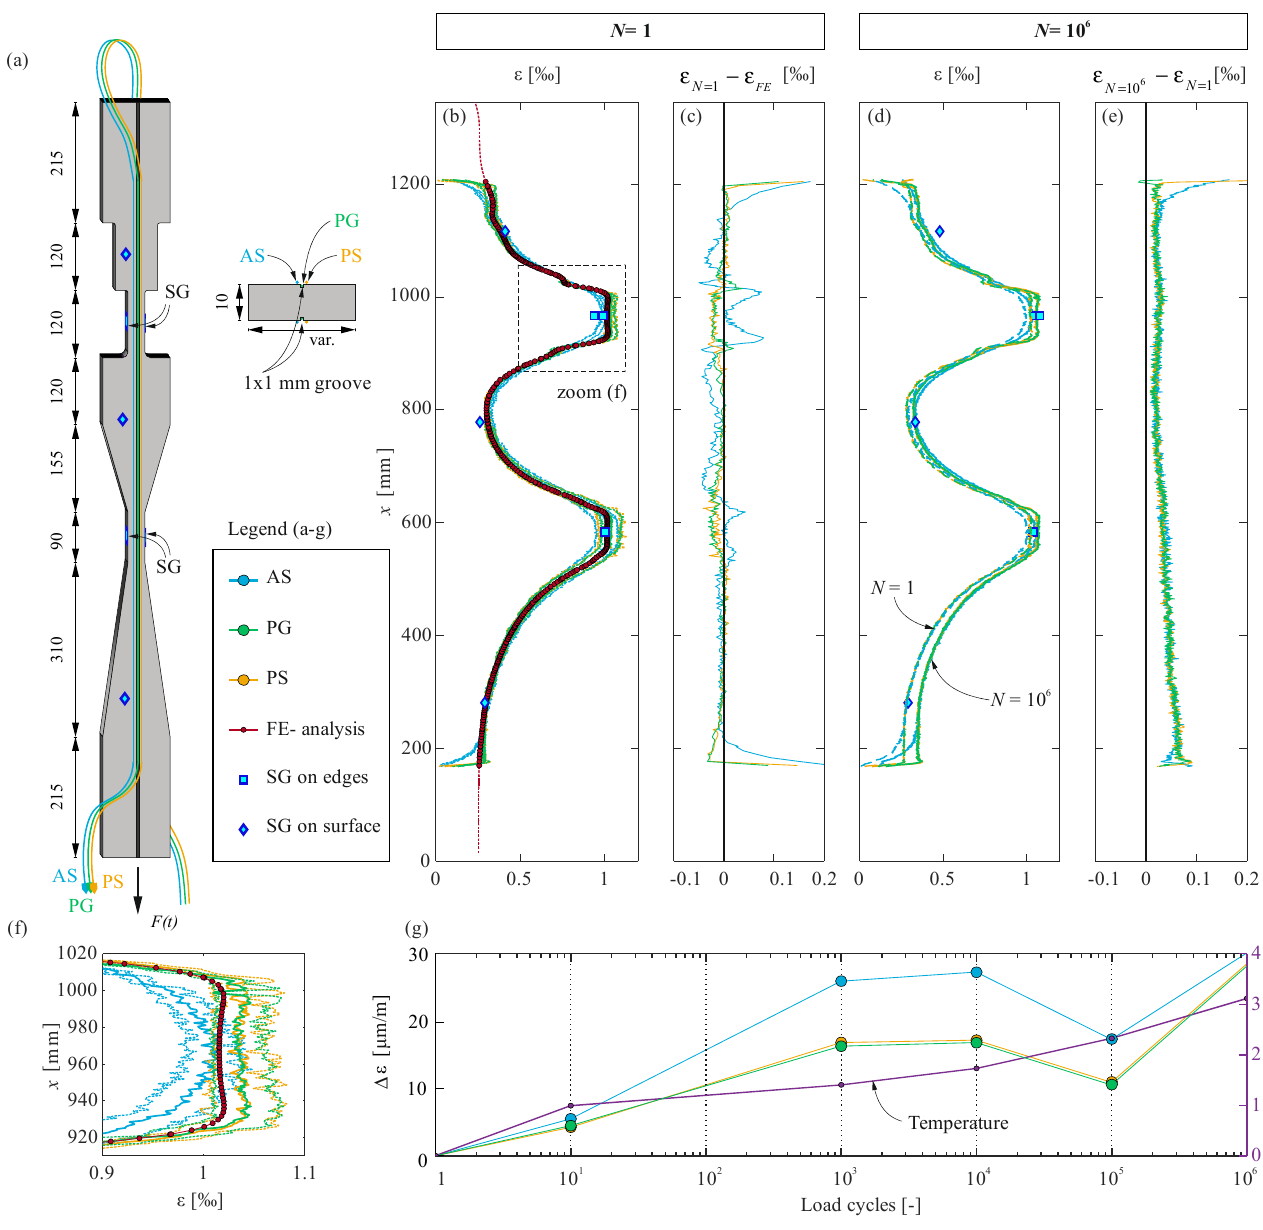
Figure 2. Influence of discontinuities, strain gradients, and repeated load cycles on DFOS measure- ments in a steel plate: ( a ) specimen layout with instrumentation (AS: acrylate FOS on the surface; PG: polyimide FOS in a groove; PS: polyimide FOS on the surface; SG: strain gauge)—dimensions in [mm]; ( b ) strain profiles and ( c ) difference between the DFOS strains and the strains simulated at the upper load of the first load cycle; ( d ) strain profiles and ( e ) difference between the DFOS strains at the upper load of the first and the millionth load cycle; ( f ) zoom to the marked window in ( b ); and ( g ) strain difference at point x = 967 mm and temperature evolution over the applied load cycles.